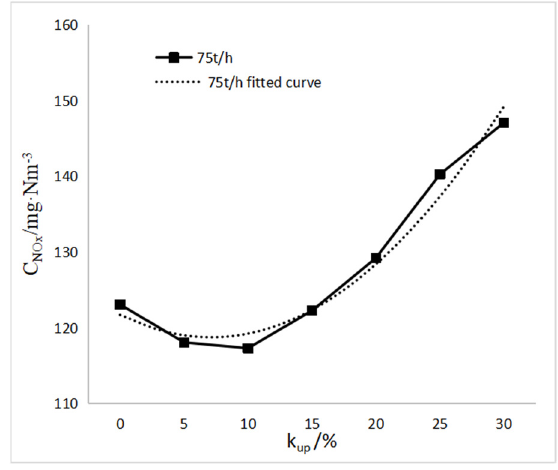
Figure 9. Influence of k up on C NOx .